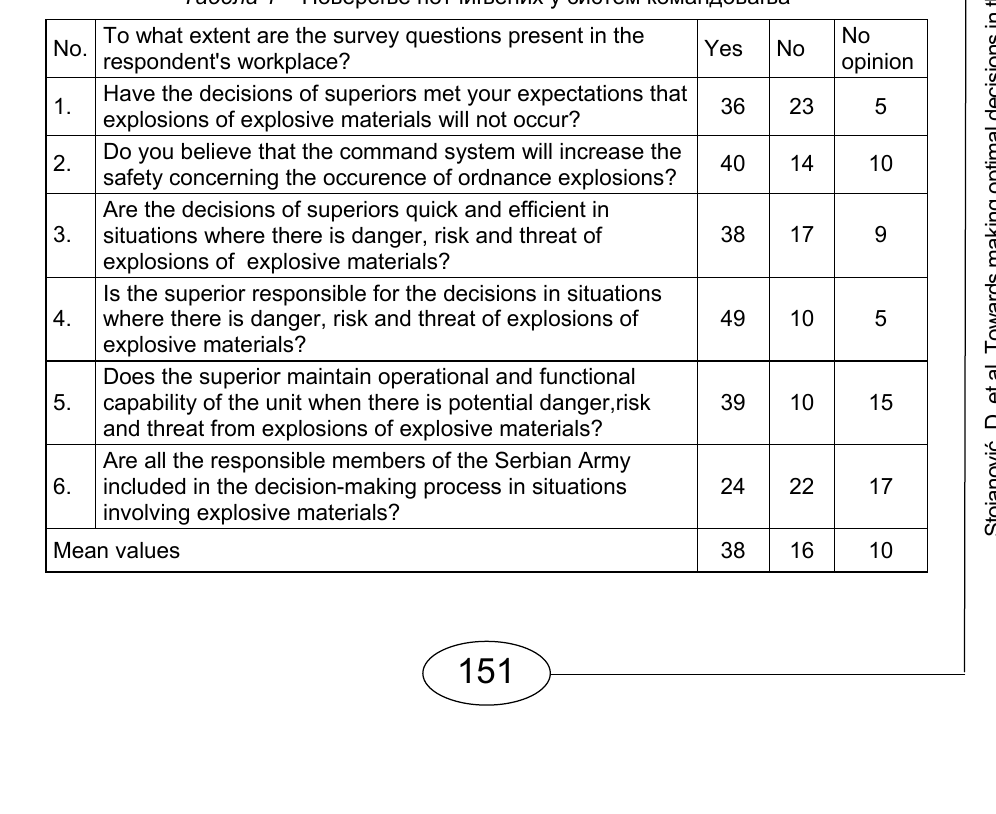
Table 1 – Trust of the subordinates in the command